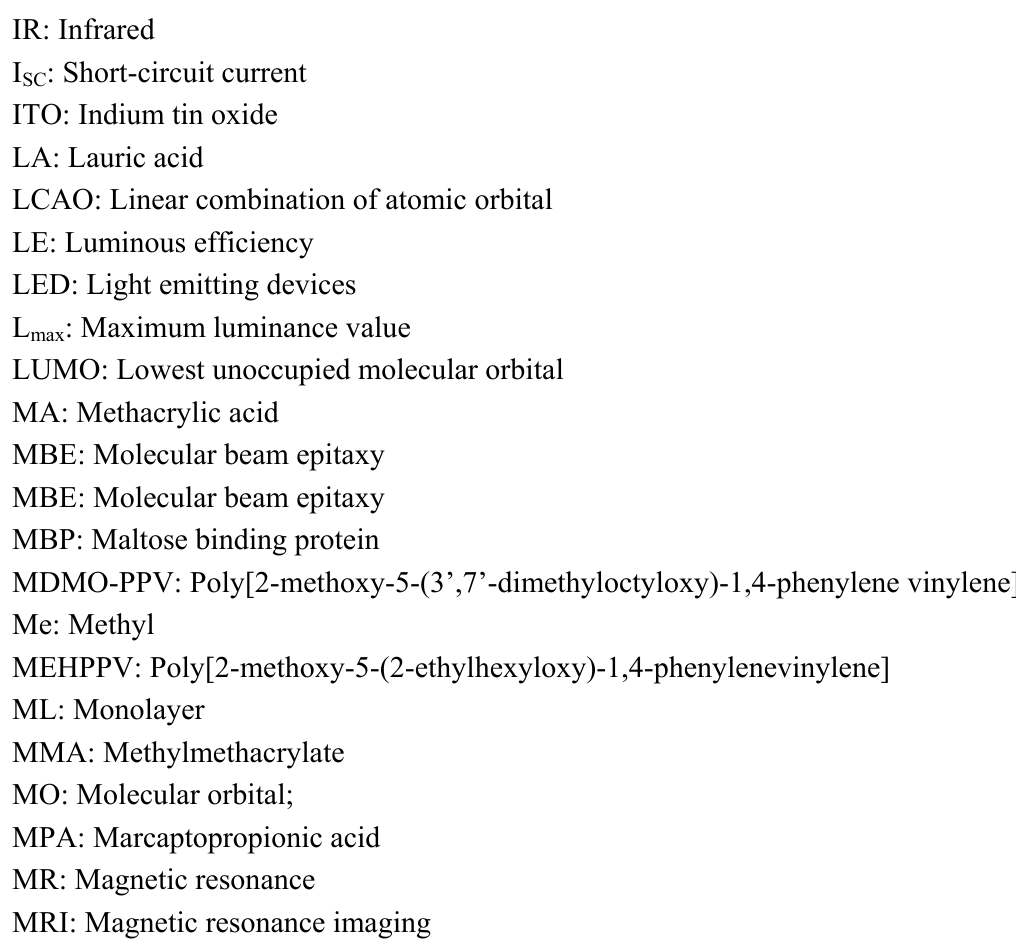
MR: Magnetic resonance MRI: Magnetic resonance imaging MWNT: Multi-wall carbon nanotubes NIR: Near